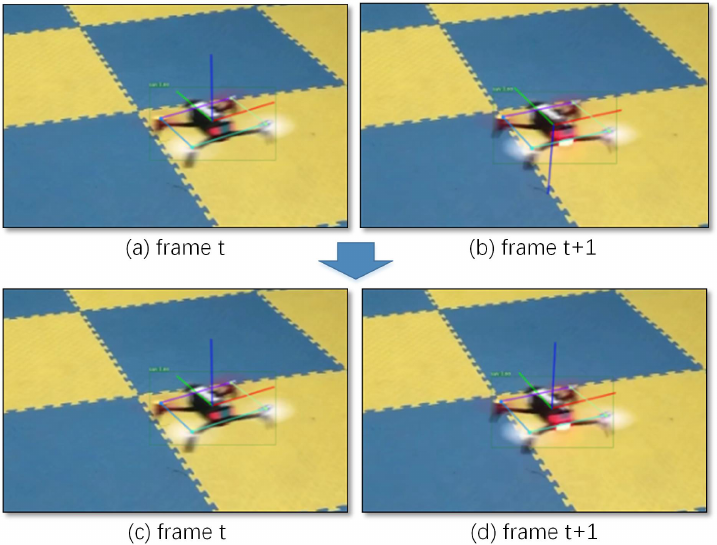
Figure 3. Solve the problem of Z axis in PnP. In two adjacent frames, t and t + 1, under similar circumstances, the Z axis of the frame t is vertical upward ( a ), and of the frame t + 1 is downward ( b ). As the Z axis we defined is upward, our improved PnP algorithm can solve the problem by a test case ( c , d ); see the text for